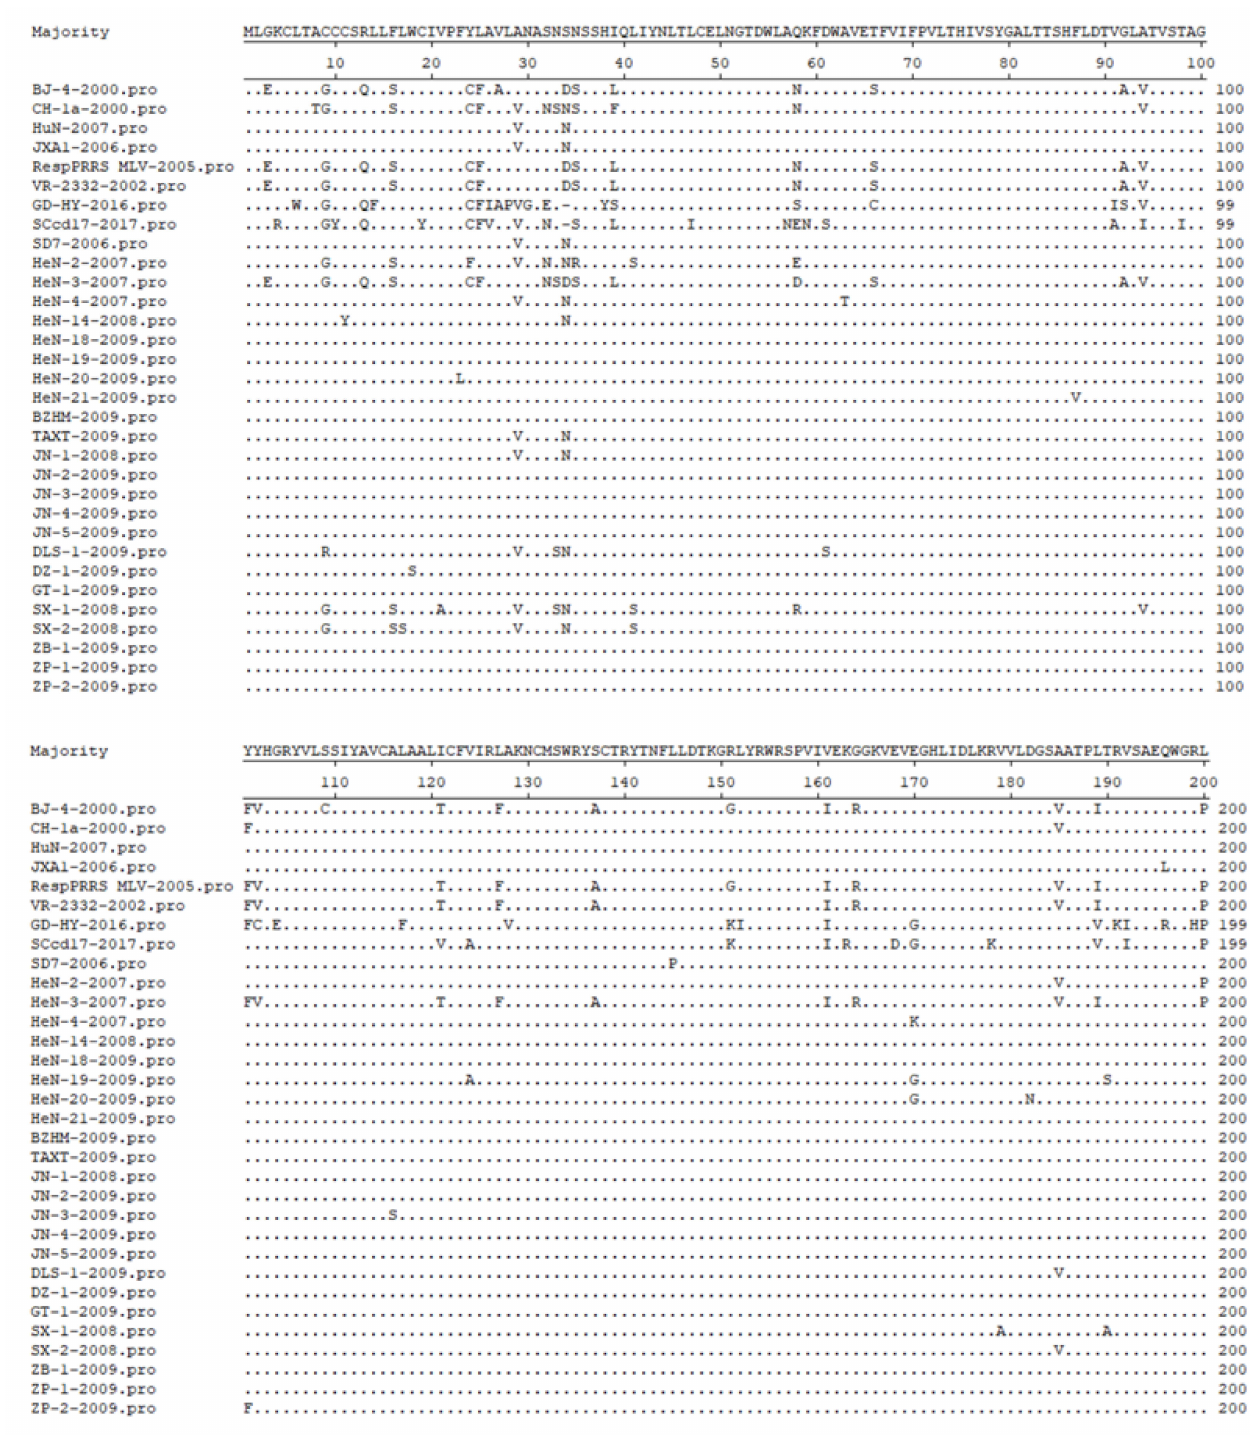
Figure 2. Alignment analysis of amino acid sequence deduced by